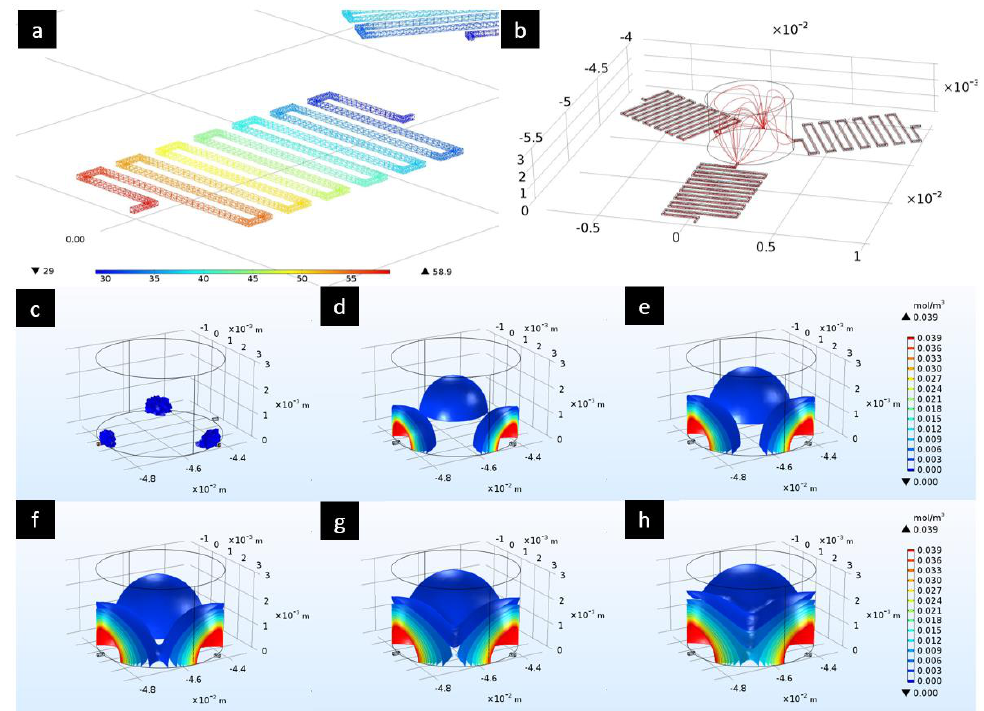
Figure 3. The top charts show the results obtained from the first simulations: ( a ) Pressure drop inside the microchannels [Pa]; ( b ) Streamlines of the laminar flow inside the microchannels and the culture chamber. Below are the results obtained from the diffusion simulation of the medium at different time instants [s]: ( c ) 0, ( d ) 300, ( e ) 500, ( f ) 650, ( g ) 800, ( h ) 1000. (For the results obtained in more time instances, see Figure S5 in Supplementary Materials).